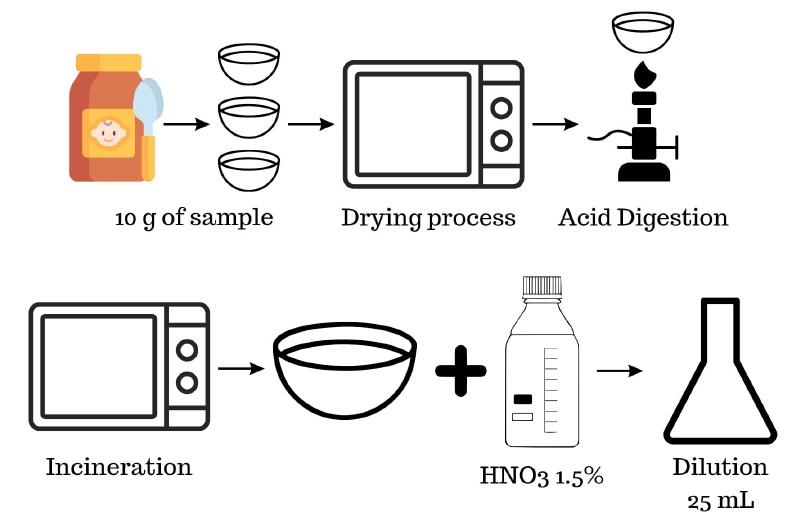
Figure 1. Experimental procedure of mineralization by incineration .